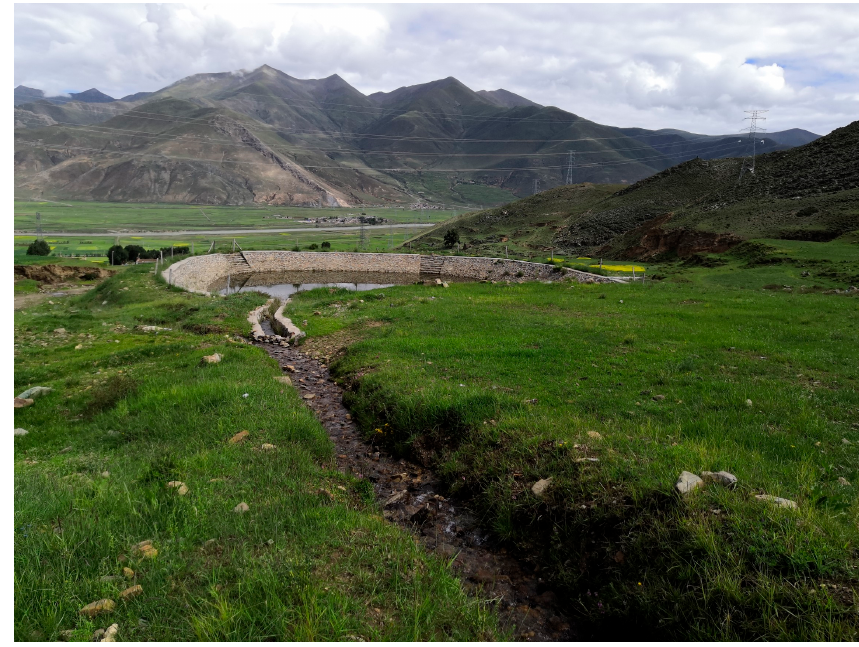
Figure 7. Pool located on an alluvial fan (Taken by Tongde Chen, 20200728). However, the distribution of grassland is less restricted by natural conditions, including altitude or slope. For example, in 2000, few grasslands (0.07%) were distributed in areas with an altitude of >5000 m, and the area percentages of grassland distributed at three altitudes of <4000, 4000–4500, and 4500–5000 m were all over 22.66%. Meanwhile, the areas of grassland distributed at slope gradients of 5 ◦ , 5 ◦ –8 ◦ , and 8 ◦ –15 ◦ were all over 18.12%. Many types of plants are distributed on alluvial fans at different altitudes, topographies, and moisture conditions